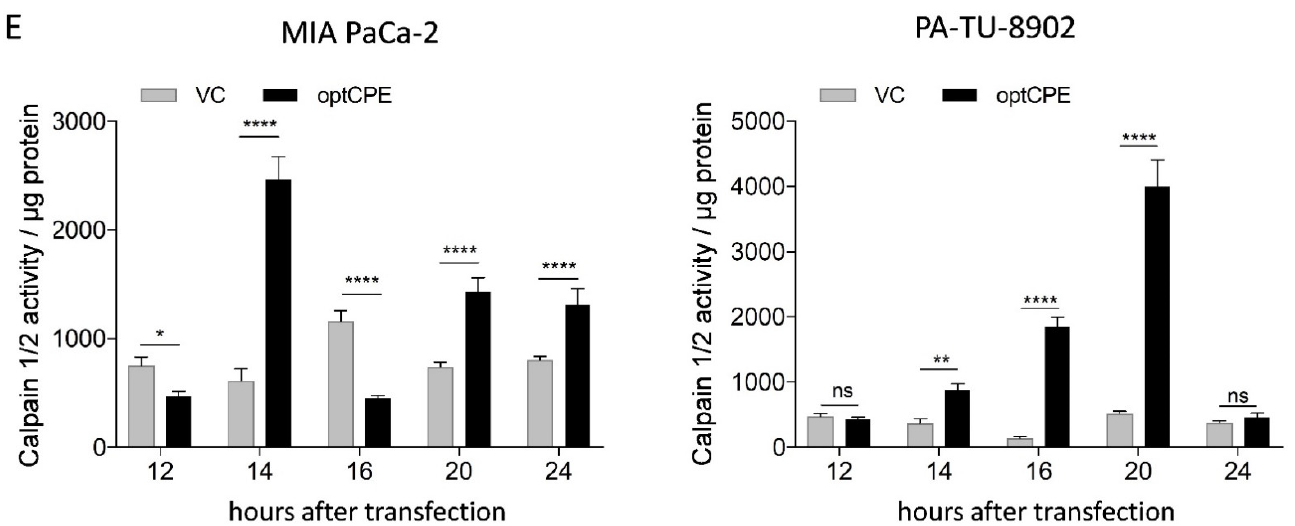
Figure 3. Time course of cytotoxicity in optCPE-transfected human PC cell lines. ( A ) Real-time live-cell analysis by In- cuCyte: CPE-mediated cytotoxic effect by analysis of calcium (Ca 2+ )(cid:31)influx (visualized by Fluo-4 AM component) and binding of Annexin-V to apoptotic cells (Annexin V Red Reagent). The optCPE gene transfer led to elevated